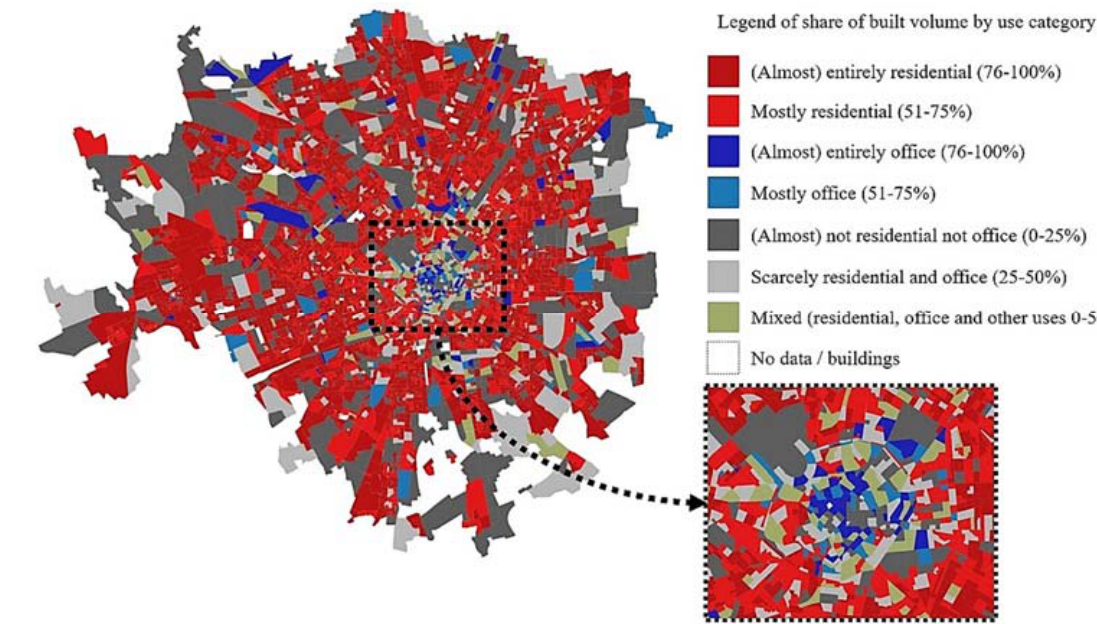
Figure 9. Map of Milan Census Units based on buildings prevailing use category.